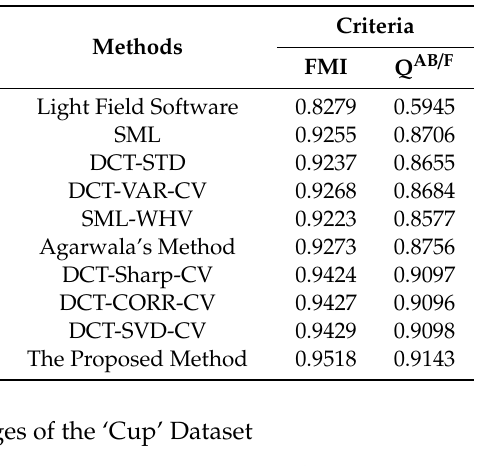
( j ) Figure 17. The expanded image ‘Cup’ image results: ( a ) Light Field Software, ( b ) SML, ( c ) DCT-STD, ( d ) DCT-VAR-CV, ( e ) SML-WHV, ( f ) Agarwala’s method, ( g ) DCT-Sharp-CV, ( h ) DCT-CORR-CV, ( i ) DCT-SVD-CV, ( j ) The Proposed Method. The performance summary of the different methods on the five image datasets using Q AB/F and FMI are listed in Table 6; Table 7, in which the top values are shown in bold. According to fusion metrics, Q AB/F and FMI, the performance of the proposed method was better than the other nine compared methods. Table 6. The performance summary of different methods on the five image datasets, using Q AB/F. Image